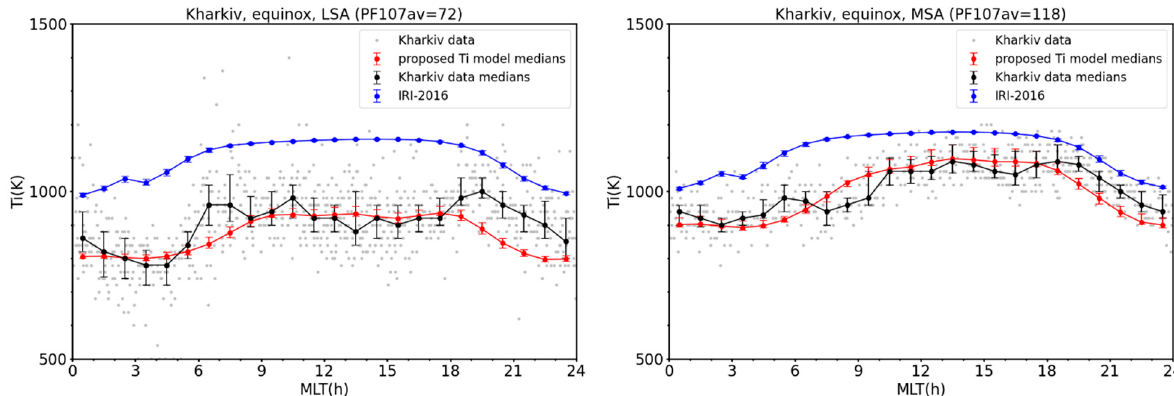
Figure 9. Local time variation of Kharkiv Ti data (grey points—individual measurements; black circles—medians in 1 h wide MLT bins; error bars represent upper and lower quartiles), corresponding medians and lower/upper quartiles from the proposed Ti and IRI-2016 models (red and blue, respectively). The left panel represents low solar activity (LSA) and the right panel represents medium solar activity (MSA).